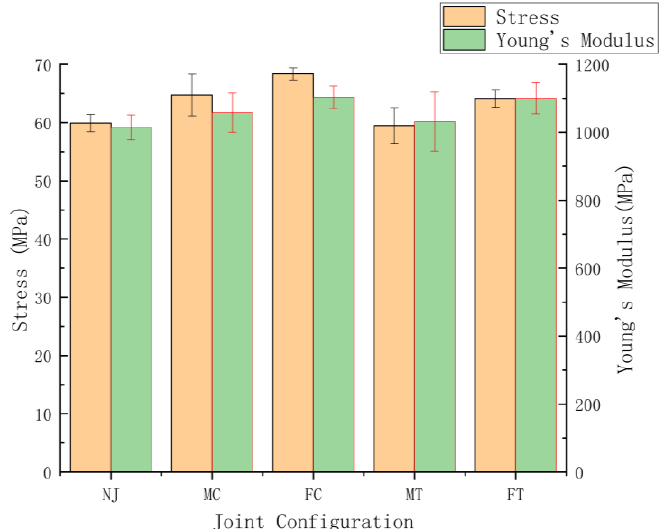
Figure 4. Graphical comparison of average stress value and Young’s Modulus for the H T series samples (75% infill density) as a function of joint samples (75% infill density) as a function of joint configuration.